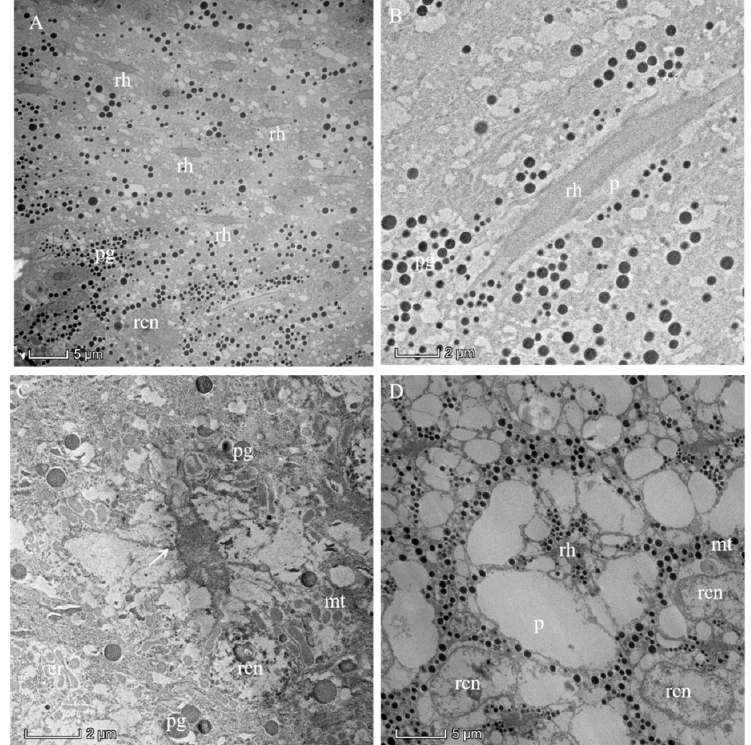
Figure 5. Proximal region of the ommatidial retina of the eye of a female Arge similis and the rhabdom in the dark-adapted state of adaptation. ( A ) Cross-section through different planes of the